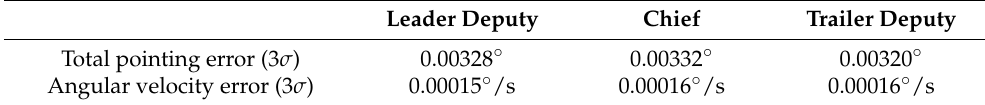
Figure 16. Attitude control simulation result: total pointing error of the chief satellite. Table 7. Attitude control accuracy of SAR mode.